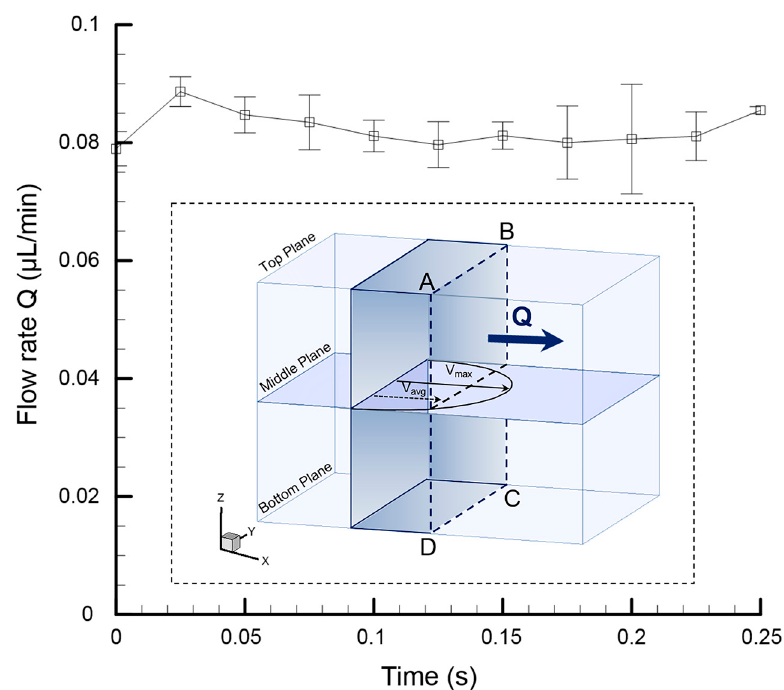
Figure 6. The net flow generated through the microfluidic device with respect to time illustrates a stable flow generated through the device. The inset picture describes the flow rate quantified by multiplying the instantaneous average flow velocity with the cross-sectional area of the microchannel.